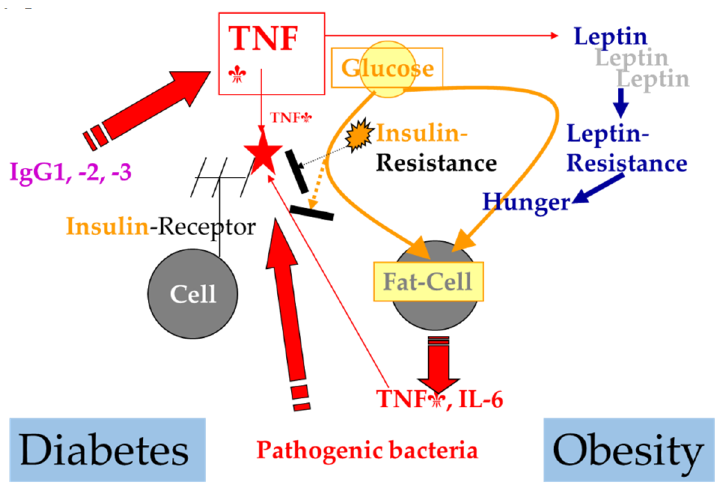
Figure 1. The evolution of the metabolic syndrome in the presence of pathogenic bacteria in the gingival crevicular fluid. The red arrow points a proinflammatory process, which leads to the secretion of cytokines (red star). The yellow arrow shows the relationship between fat mass and insulin resistance, and the blue arrow shows hormonal changes (leptin) caused by cytokines, which leads to overeating, and thus increased fat mass.